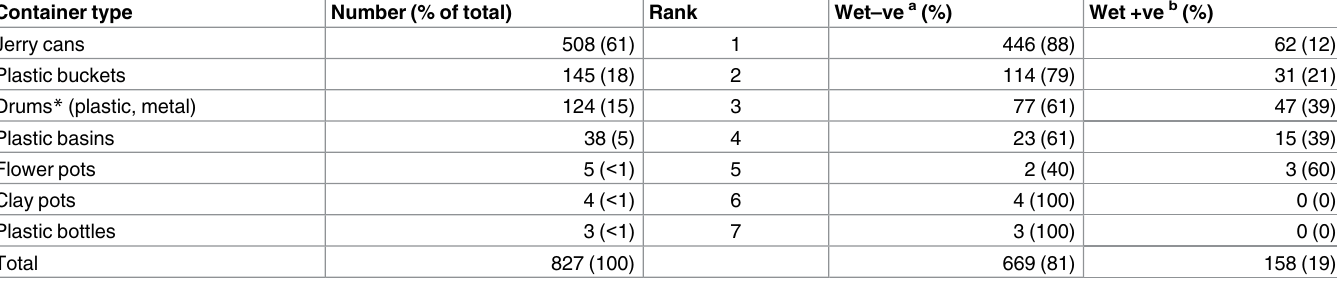
Table 1. Rank distribution of wet containers sampled indoors and immature Ae . aegypti positivity by container type in Mombasa city during the outbreaks.